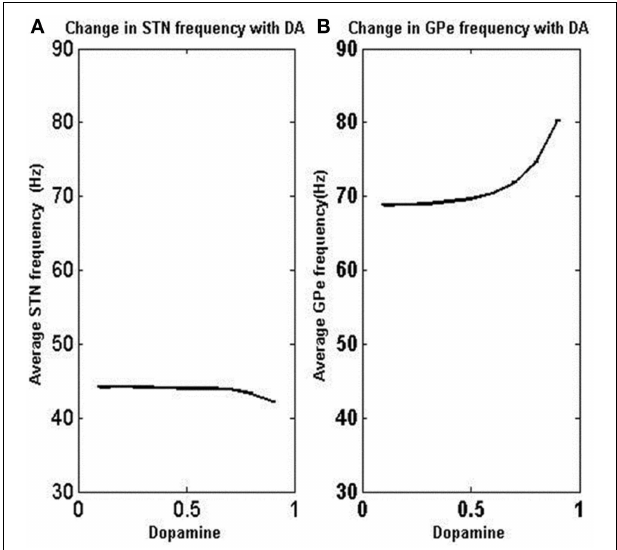
FIGURE 8 | Variation of average firing rate of STN and GPe neurons with DA levels. As the dopamine level is increased, the firing rate increased in GPe neurons but decreased in STN neurons. X-axis indicates the level of dopamine and y-axis is the firing rate of respective neurons. (A) Shows the change in STN frequency with increase in DA level. (B) Shows the change in GPe frequency with increase in DA